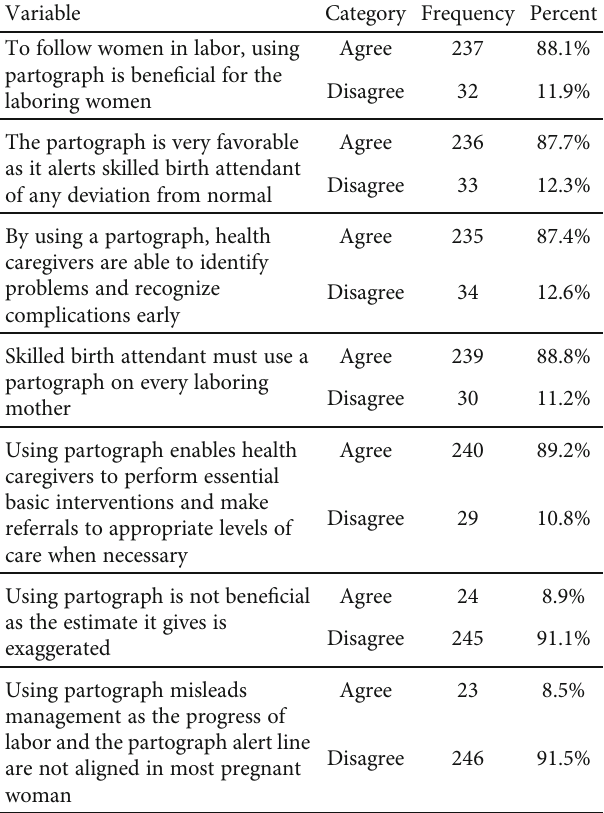
Table 3: Attitude of obstetric caregivers towards partograph utilization in Wolaita Zone, Southern Ethiopia, 2017 ( n = 269